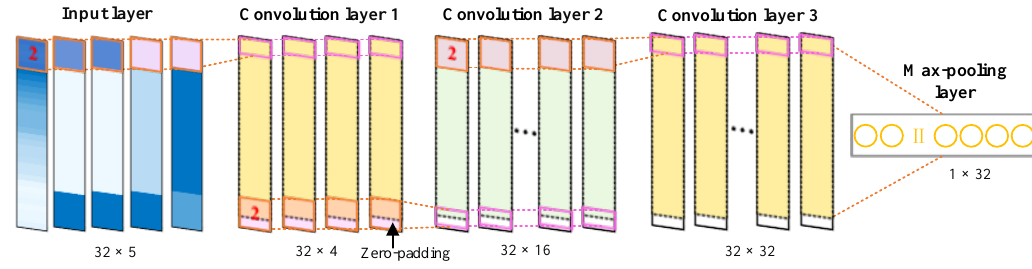
Figure 5. The structure of the Convolutional Neural Network (CNN).